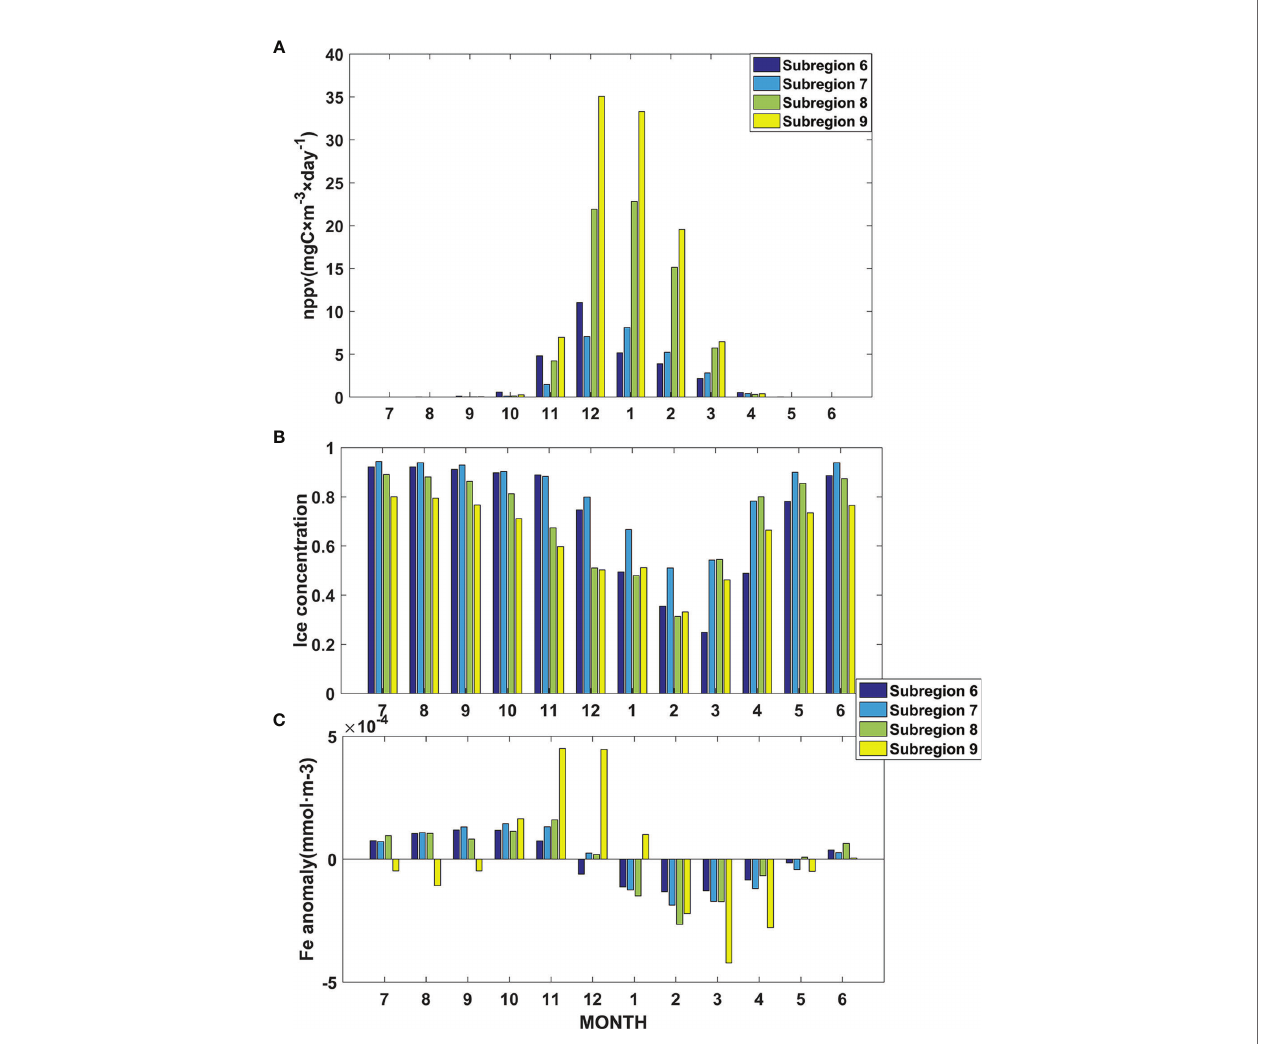
FIGURE 7 | (A) Monthly mean net primary productivity values in bioregions 6, 7, 8, and 9 from 1993 to 2015; (B) Monthly mean ice concentration in bioregions 6, 7, 8, and 9 from 1993 to 2015; (C) Monthly mean dissolved iron anomaly in bioregions 6, 7, 8, and 9 from 1993 to